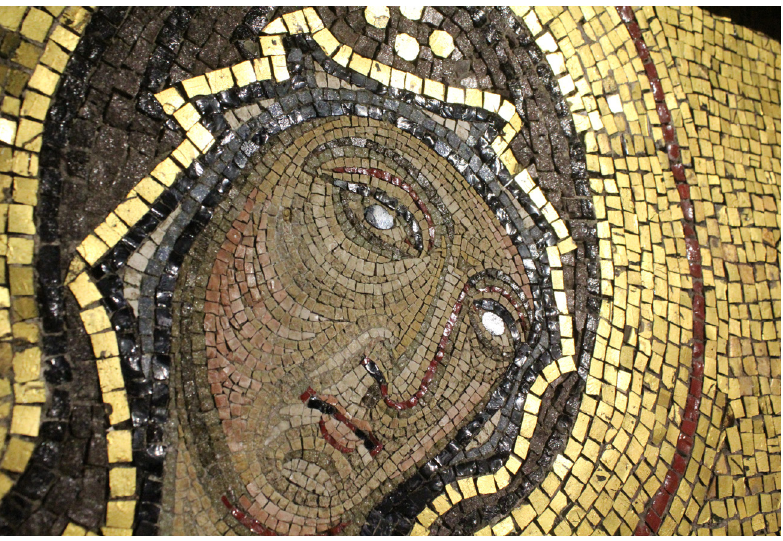
Figure 5: Palermo, St. Mary of the Admiral, Dedication panel, The Virgin Mary , face’s detail, glittering eyes (photo V. Cantone).